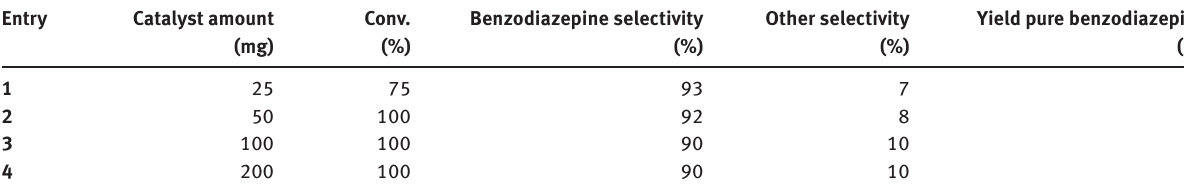
Table 7: Catalyst amount